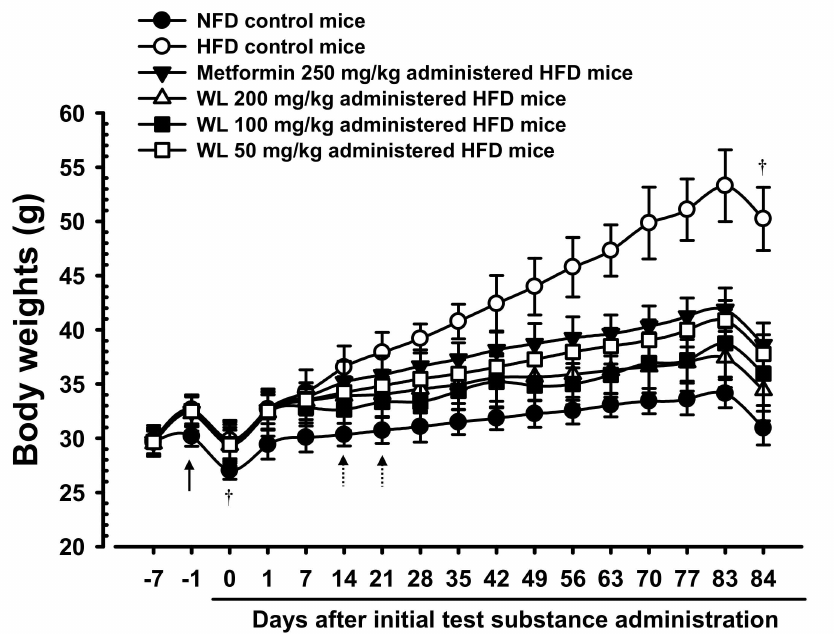
Figure 1. Body weight changes in NFD or HFD supplied mice. HFD control group showed significant ( p < 0.01) increases of body weights as compared with intact group from 6 days after HFD supply (Arrow), however, significant ( p < 0.01 or p < 0.05) decreases of the body weights were identified in all three di ff erent dosages of WL 200, 100, and 50 mg / kg groups from 14 days after first administration as compared with HFD control group, dose-dependently, and from 21 days after first administration in metformin group compared with HFD control group, respectively (Dot arrows). Values are shown as mean ± SD of eight mice. NFD = Normal pellet diet; HFD = 45% Kcal high-fat diet; WL = Wasabi Leaf / Folium, Wasabia japonica (Miq.) Matsum extracts. All animals were overnight fasted before first test material administrations and sacrifice ( † ). Day − 7 means 7 days before initial test material administration; Day 0 means the day of initial test material administration; Day 84 means 1 day after last 84th test material